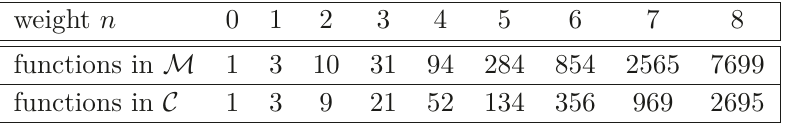
Table 4. Number of functions in M and in the trimmed space C , as a function of the weight.